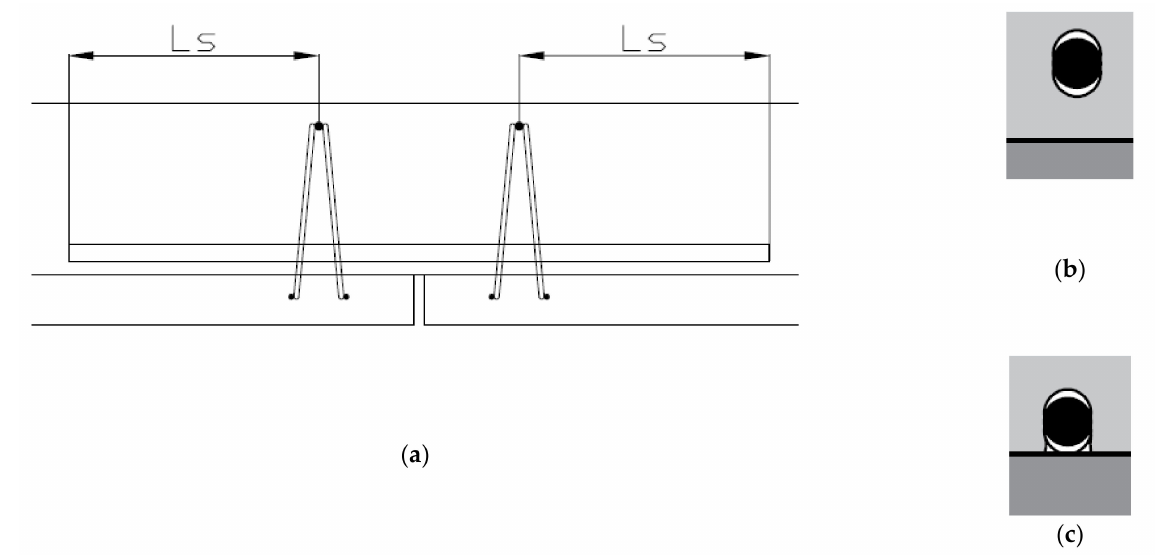
Figure 12. Determination of overlap length: ( a ) effective overlap length; ( b ) bond of a concrete bar fully enveloped or partially enveloped ( c ) with friction part (nonfilled area) at the